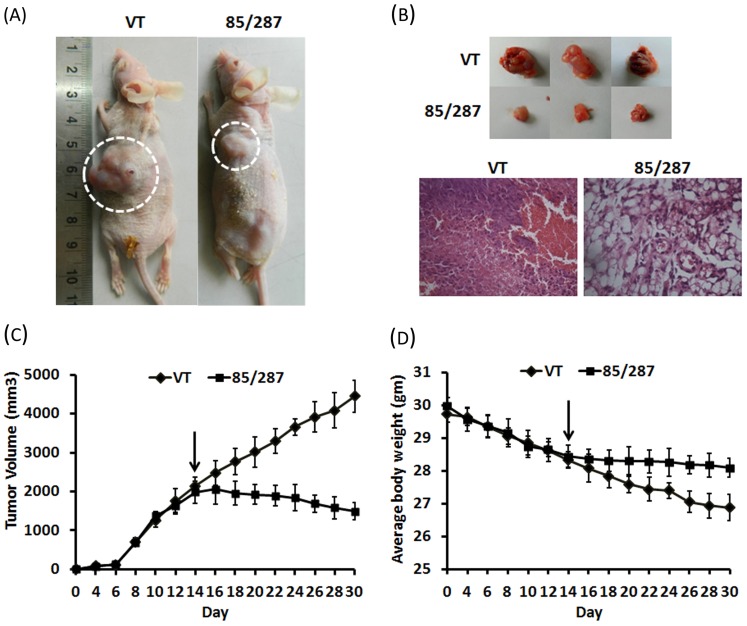
Effect of CDRI-85/287 on tumor regression in MDA-MB 231 xenograft mouse model.(A) Representative images of MDA-MB 231 xenograft nude mice showing regression in tumor volume after treatment with CDRI-85/287(10 mg/kg, p.o.) in comparison to vehicle treated (VT) group. (B) Upper panel shows the dissected out tumors from vehicle treated and CDRI-85/287 treated xenograft mice. Lower panel shows representative images of hematoxylin and eosin stained tissue sections from vehicle- and CDRI-85/287 treated groups. (C) Graph showing tumor volume changes within 16 days after initiation of treatment (marked by arrow). Number of animals per group  =  6 to 8. (D) The average body weights of the mice during tumor development and treatment (marked by arrow). Number of animals per group  =  6 to 8.